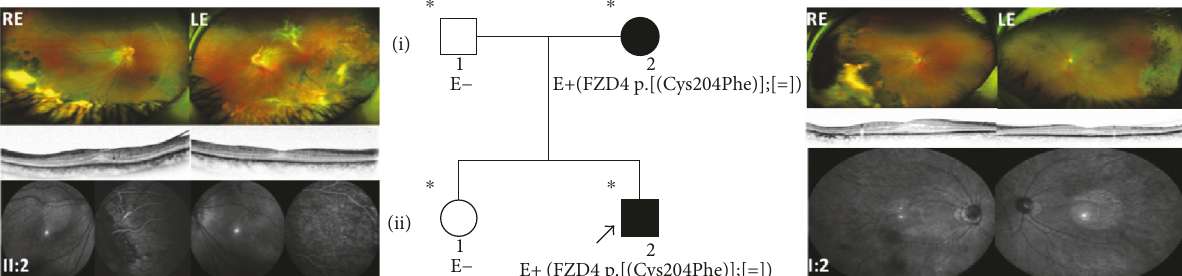
Figure 3: Pedigree and ocular features of family 3. Daytona wide- fi eld color fundus photos and OCT scans of the proband (II:2) at the age of 19 years with bilateral exudative manifestation of FEVR stage 4A. Peripheral retinal signs of cryo treatment and Argon laser barrage, performed after evidence of fl uorangiographic leakage, can be seen in the inferior temporal sectors in both eyes. Daytona wide- fi eld color fundus photographs of the proband ’ s mother (I:2), showing treatment with Argon laser in the retinal periphery of both eyes. Angiograms from the posterior pole and from the midperiphery do not present signs of disease ’ s activity after laser treatment. ∗ Documented clinical evaluation; E+ and E − , positive and negative to genetic test, respectively; RE, right eye; LE, left eye.